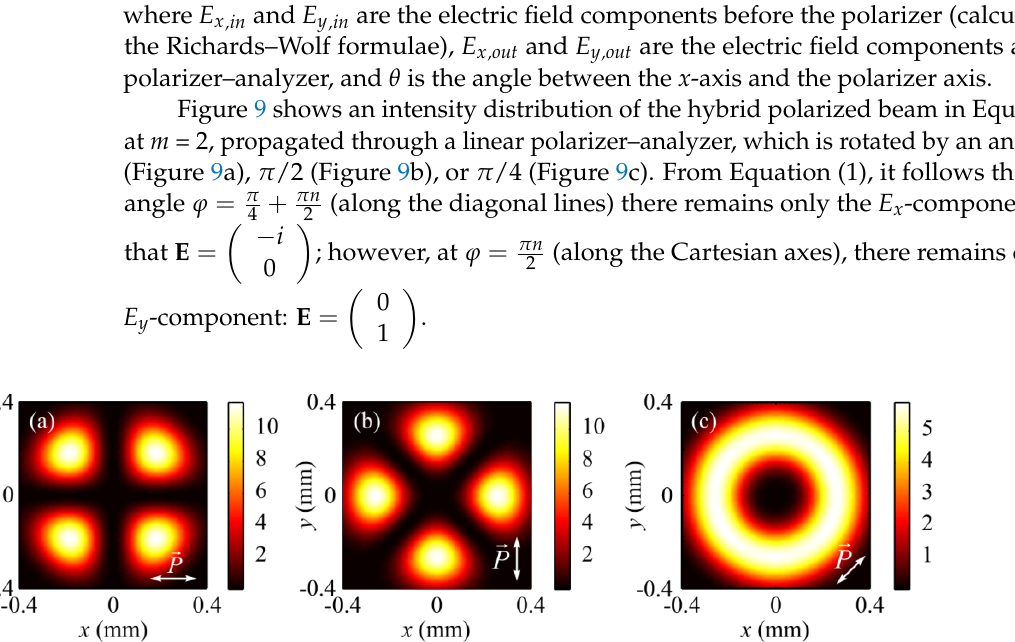
Figure 9. Intensity distribution (simulation) of a hybrid beam (Equation (1)) with m = 2 propagated through a linear polarizer–analyzer rotated by the angle θ equal to 0 ( a ), π /2 ( b ), and π /4 ( c ).